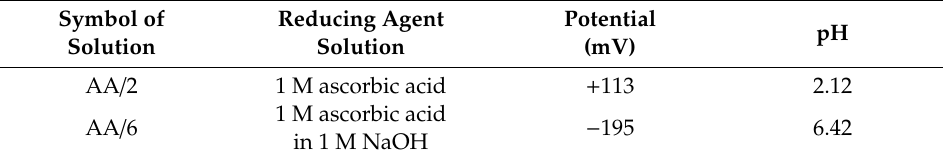
Table 1. Reducer